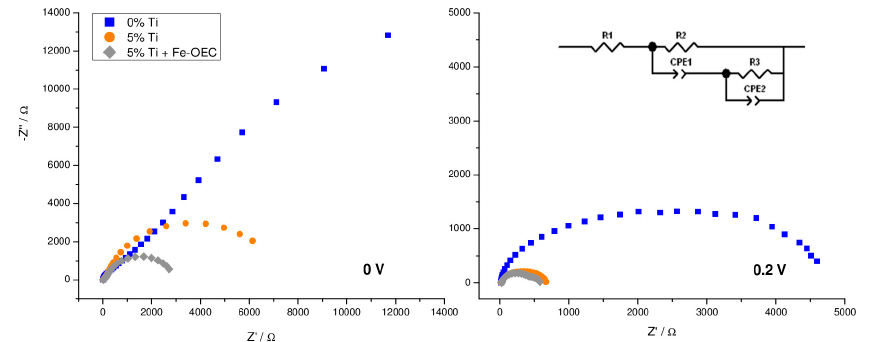
Figure 9. Nyquist plots recorded under AM 1.5G illumination in 0.1 M NaOH (pH 13.3) of un-modified (blue squares) and 5% Ti-modified hematite electrodes before (orange circles) and after functionalization with Fe-OEC (grey diamonds) at two selected potentials vs. SCE. The circuital model used for data fitting is reported as an inset.